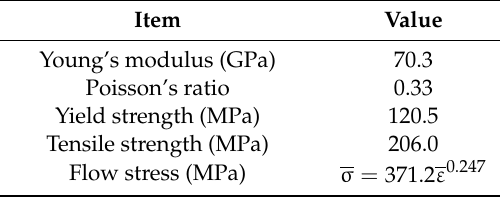
Figure 2. Multi-material clutch drum. Table 1. Mechanical properties of Al5052.